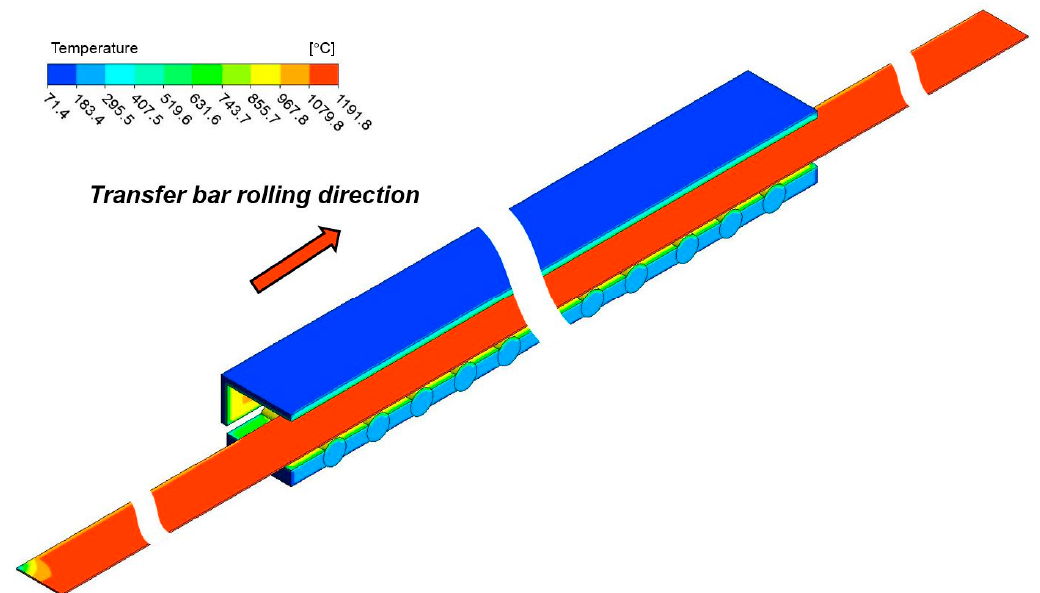
251 Figure 9. Temperature contours of the traditional passive heat retention panel model (overall view).